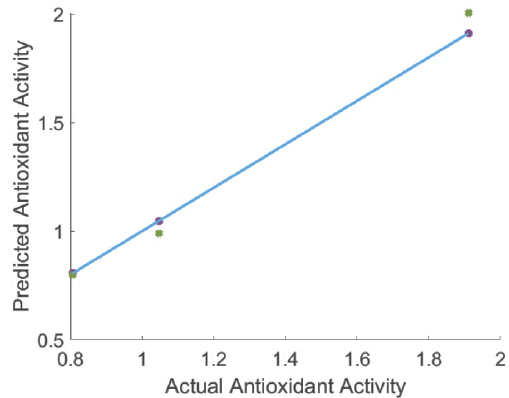
Figure 8. Actual vs. predicted target value plot. Purple dots depict the actual target values of the test instances and green crosses represent the predicted target values.